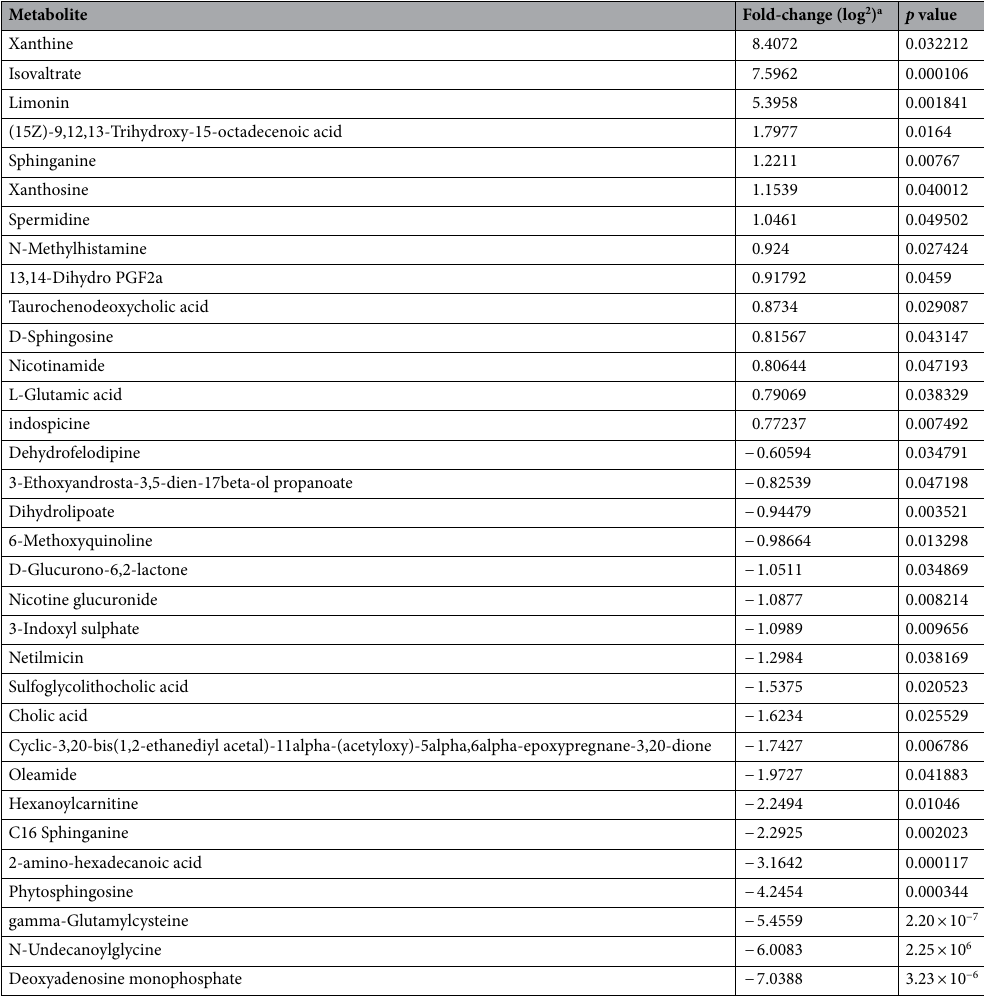
Table 1. List of metabolites in PKO against HFD. a Fold change values described are the ratio of PKO/HFD. The values are arranged from highest ratio (up-regulated) to the lowest